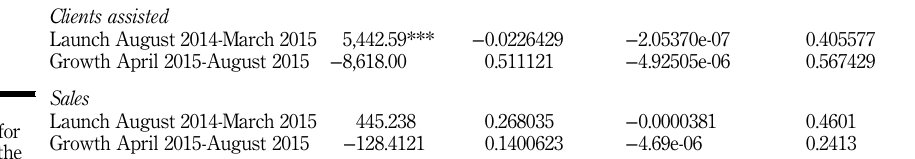
Table AIII. MOLS estimation for the C4 Cactus for the different sub